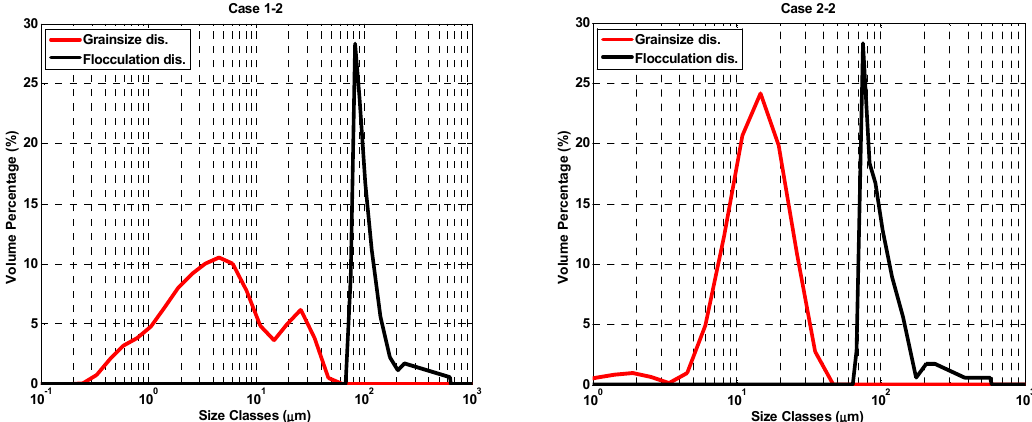
Figure 7. Comparison of initial grain size and flocculation grain size.